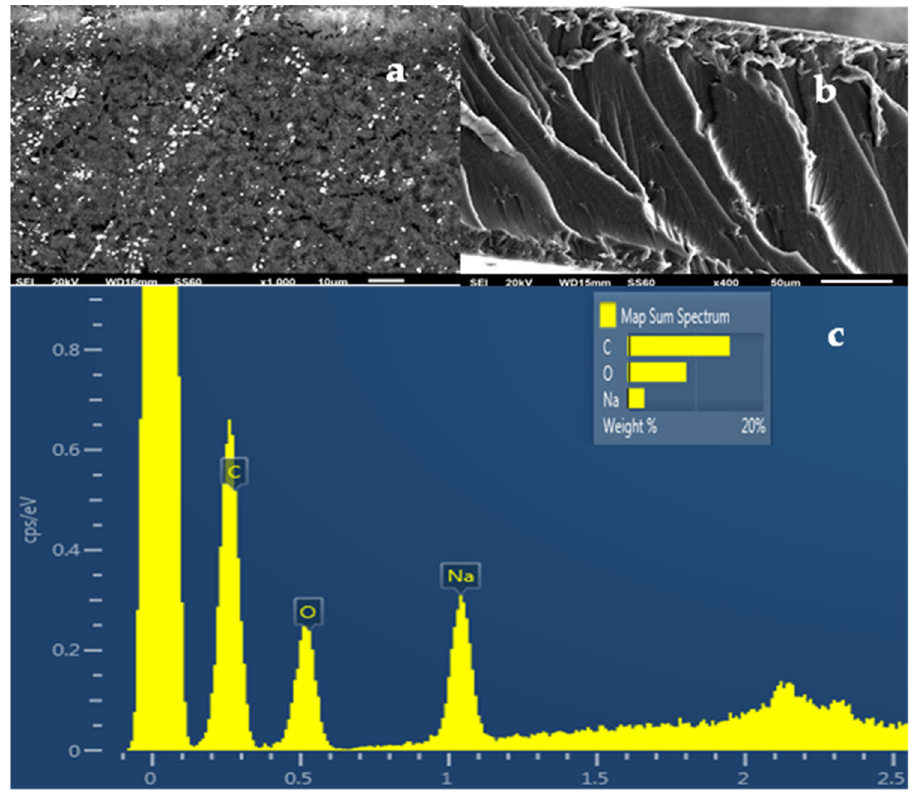
Figure 6. ( a ) SEM images of the surface and ( b ) cross-section for the pure film of ALG/G. ( c ) Energy dispersive spectrometer (EDS) spectrum and relative elemental analysis of the surface (inset) from the SEM image ( a ).